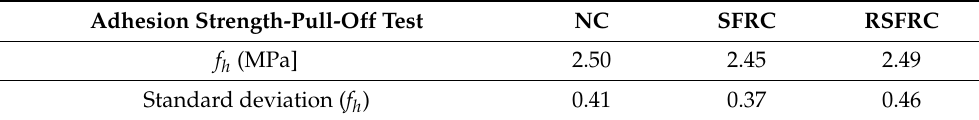
Table 6. Results of pull-off peel tests.